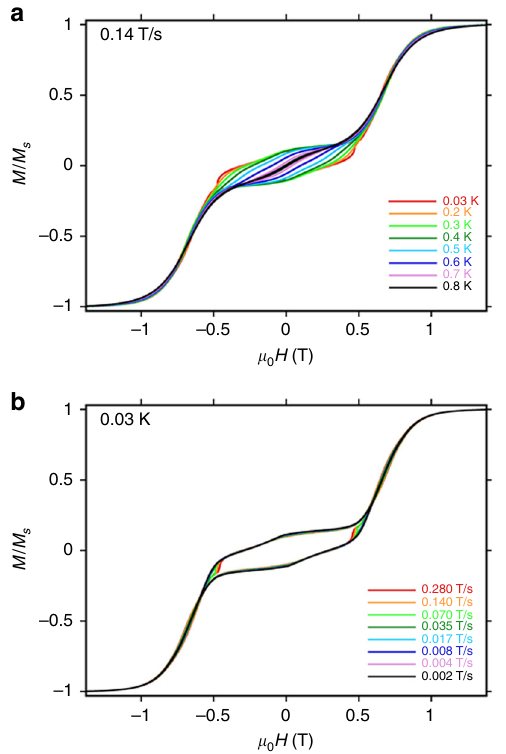
Fig. 3 Single-crystal studies. Single-crystal magnetization ( M ) vs. applied fi eld measurements ( μ -SQUID) for complex 1 at a 0.03 – 0.8 K with the scan rate of 0.14 T s − 1 ; b with different fi eld sweep rates at 0.03 K